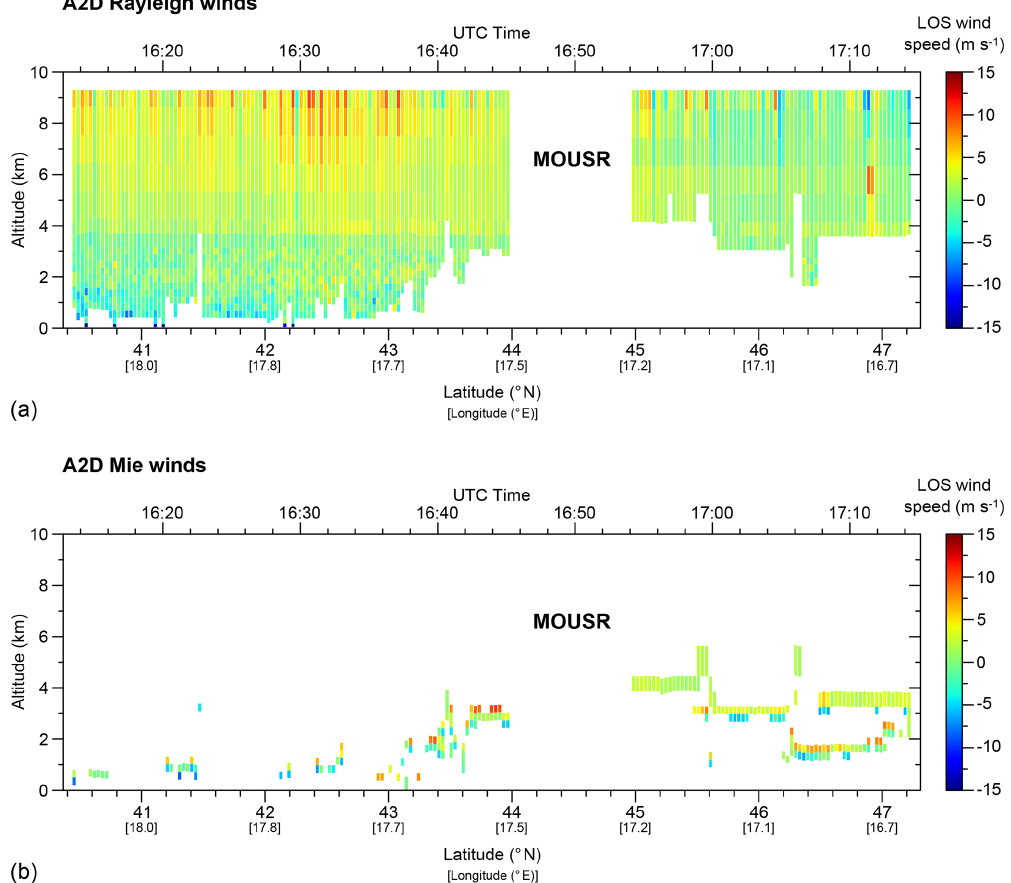
Figure 4. LOS wind profiles (positive if winds are blowing away from the instrument) measured during the underflight on 22 November 2018 between 16:13 and 17:15UTC along the Aeolus measurement track (white arrow in Fig. 2) using (a) the A2D Rayleigh and (b) Mie channels. White areas represent missing or invalid data due to low signal, e.g. below dense clouds. The data gap between 16:45 and 16:54UTC is due to an interruption of the wind measurement during a different operation mode (MOUSR) of the A2D instrument that aimed at the detection of the Rayleigh background signals on the Mie